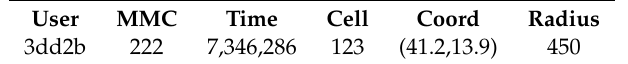
Figure 1. Structure of a call detail record (CDR). Every time a user sends or receives calls or text messages we generate one CDR with information about the user (hashed) id, the MMC (mobile country code), the timestamp of the CDR, and the code, coordinates and coverage radius of the cell tower.